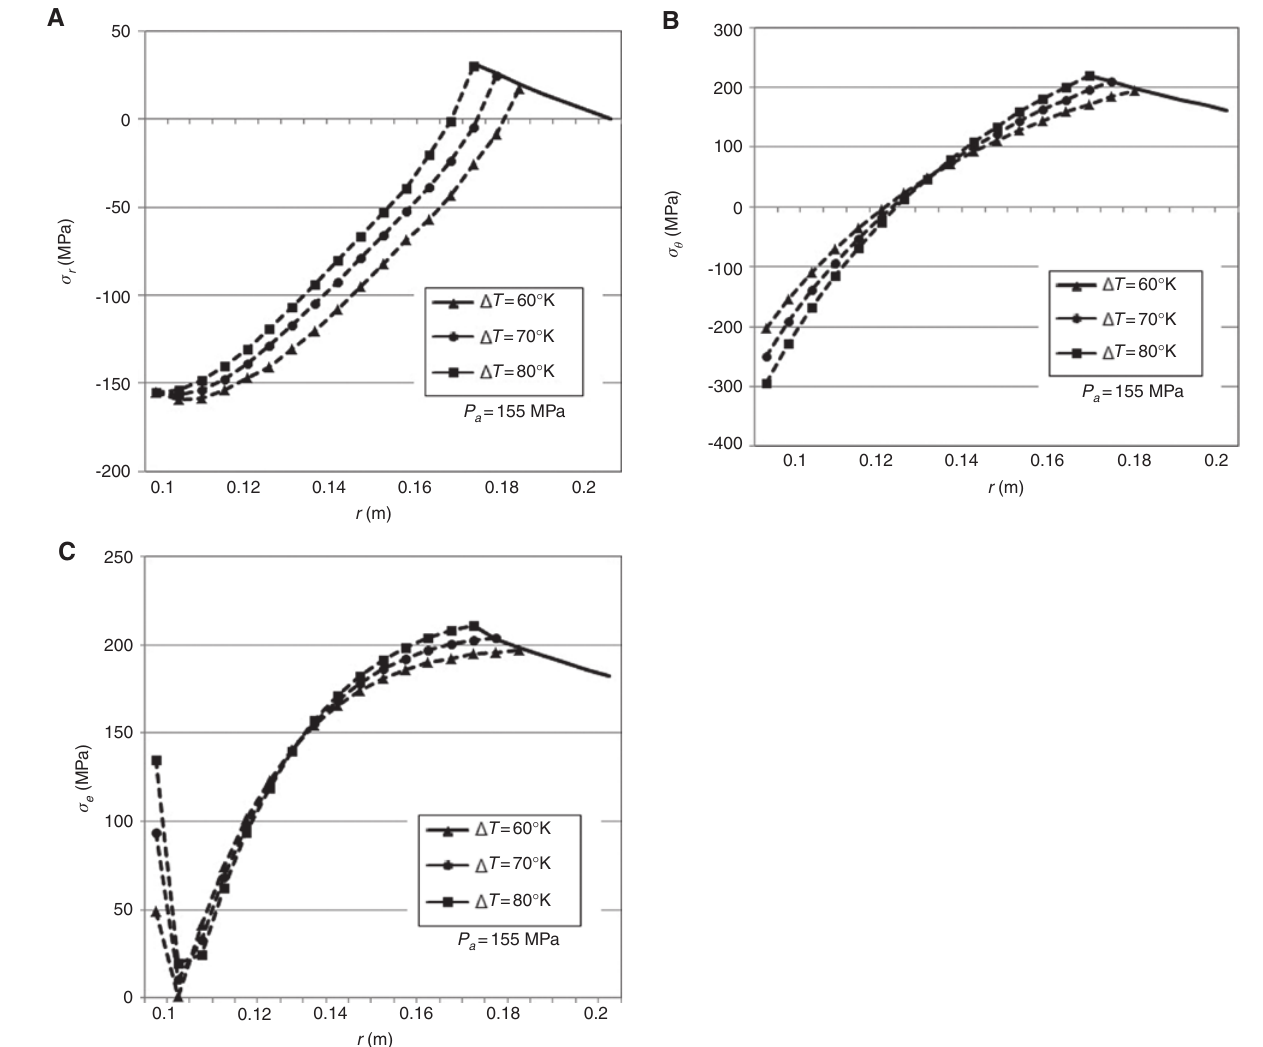
Figure 6. The temperature gradient for this case has been considered to be constant and equal to Δ T = 100 ° K. For this case also, there are some points in the radial direction that the effective stresses become zero.